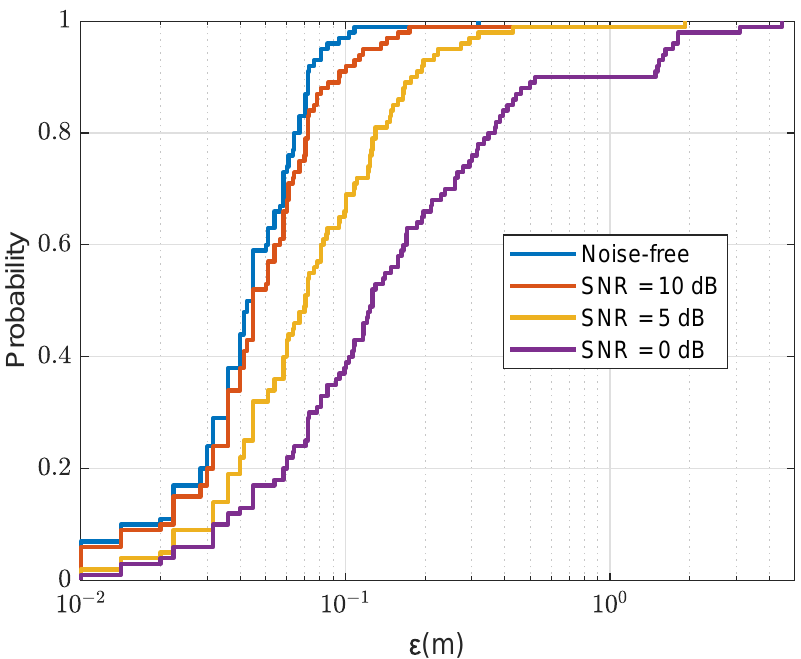
Figure 20. CDF for the localization error ε in the acoustic environment with the SWellEx-96 SSP against the SNR of channel response estimation; N T = 4; N max = 4, nine points are removed after finding the next coarse AF maximum; the refinement steps, F r = F d = 0.1 m; the size of the refinement area is 4 m × 4 m (as shown in Figure